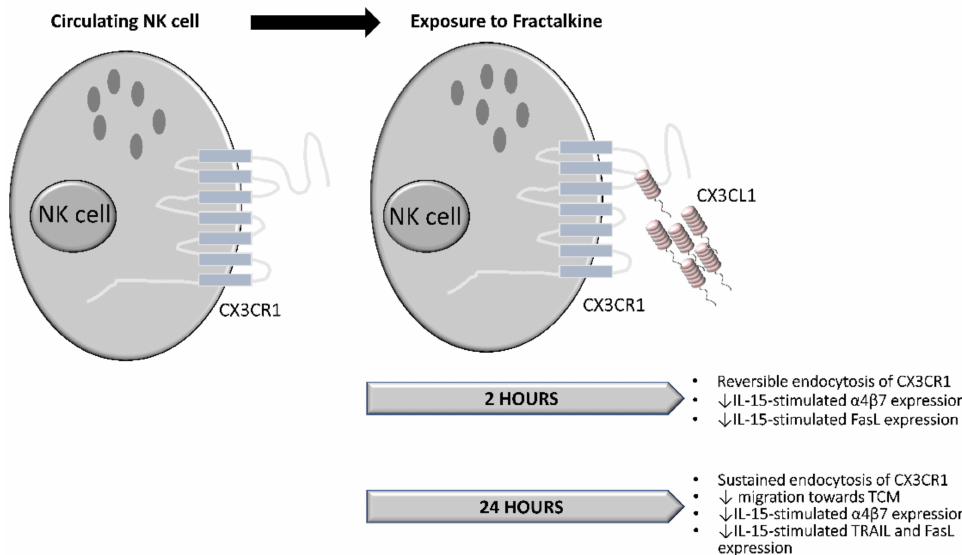
Figure 7. NK cell fate following exposure to fractalkine. Circulating NK cells are exposed to fractalkine. After 2 h of exposure there is reversible endocytosis of CX3CR1. When NK cells are